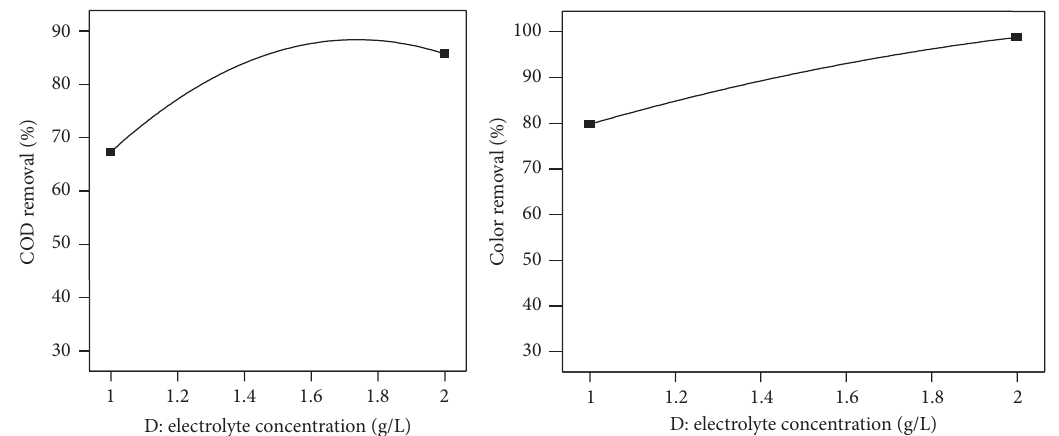
Figure 5: Effect of electrolyte concentration on COD and color removal.